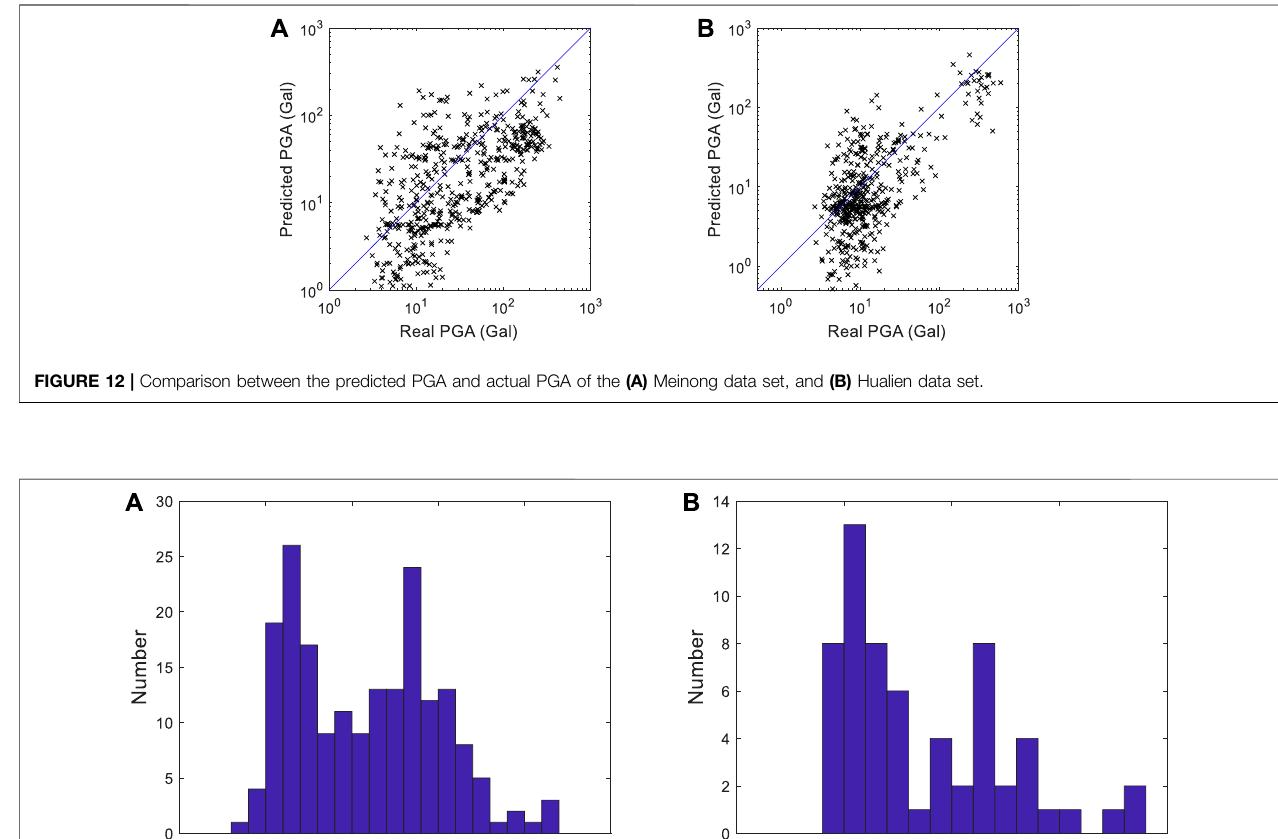
Figure 13 and Table 3 . Although the predicted PGA was larger than the threshold for all the cases with a negative lead time, these cases were classi fi ed as FN due to late alerts, whose locations are